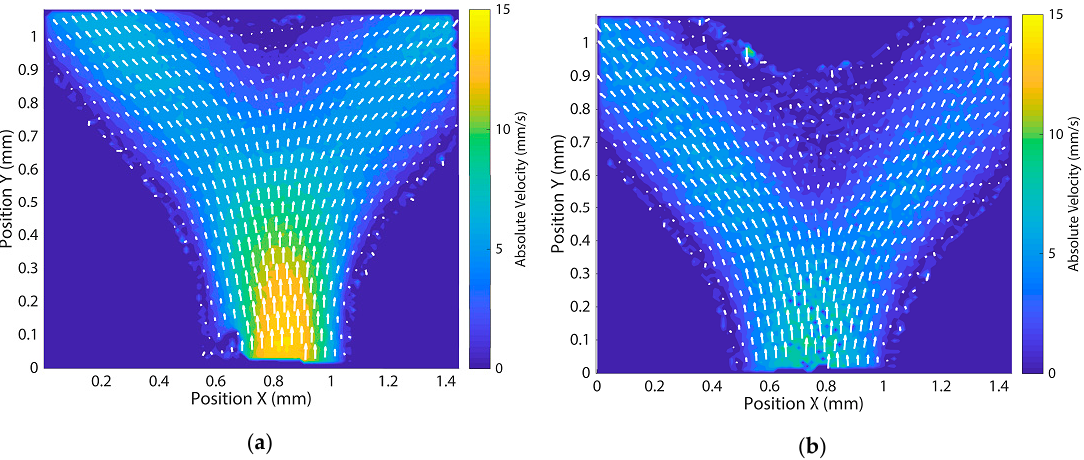
Figure A7. PIV measurement results for the second order bifurcating network with square cross-sectional channels (500 × 500 µm) at the first bifurcating point. Flow is from bottom to top of the images. Vectors indicate flow direction and absolute velocity. Absolute velocity is also represented in the colour coding of the flow field. ( a ) Flow direction and absolute velocity measured at midplane, showing a similar flow profile as the circular channel; ( b ) Flow direction and absolute velocity measured below midplane (at quarterplane) showing a more flattened flow profile. Moreover, the appearance of low velocity flow areas becomes more apparent, especially at the bifurcation point where a larger region of lower flow velocities is observed compared to the midplane measurement.